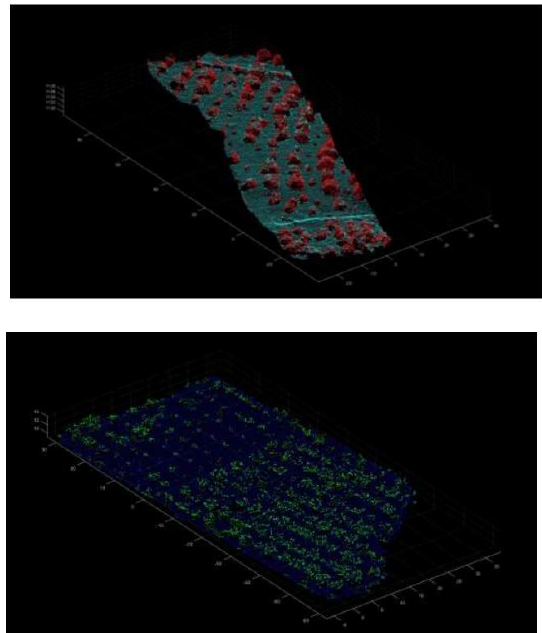
Figure 9. Watershed-segmentation algorithm